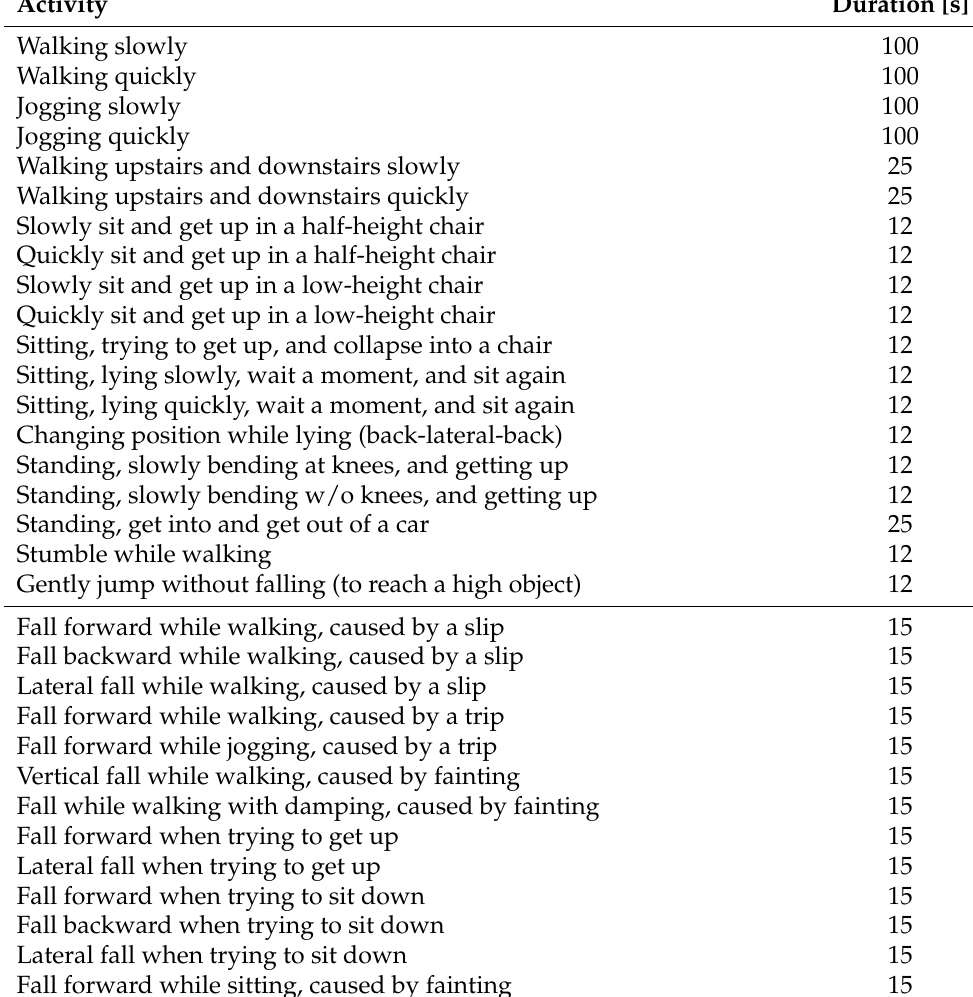
Table 3. Details of the Activities of Daily Living and falls contained in the SisFall dataset